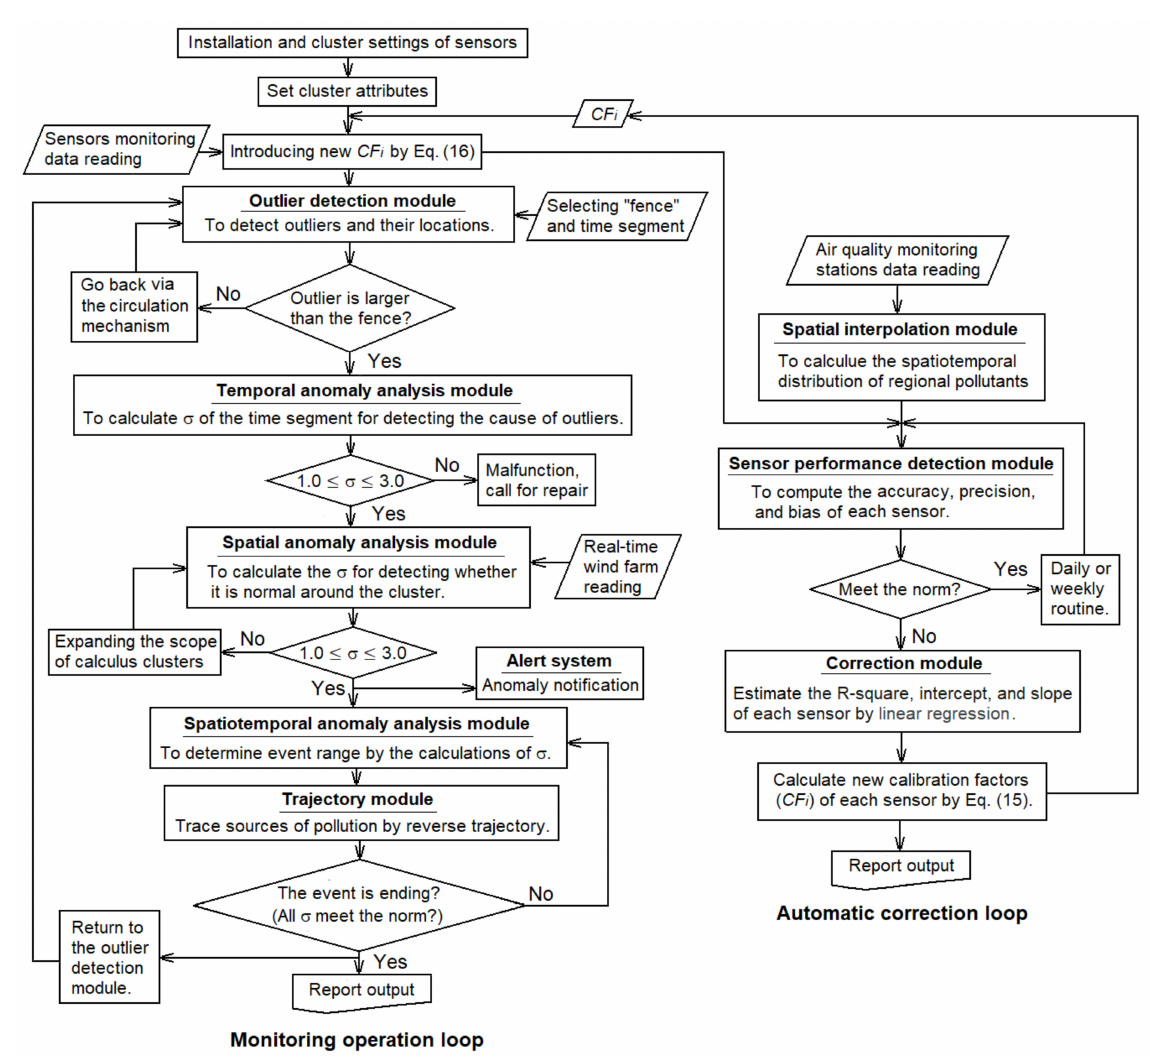
Figure 12. The flowchart of a suggested working